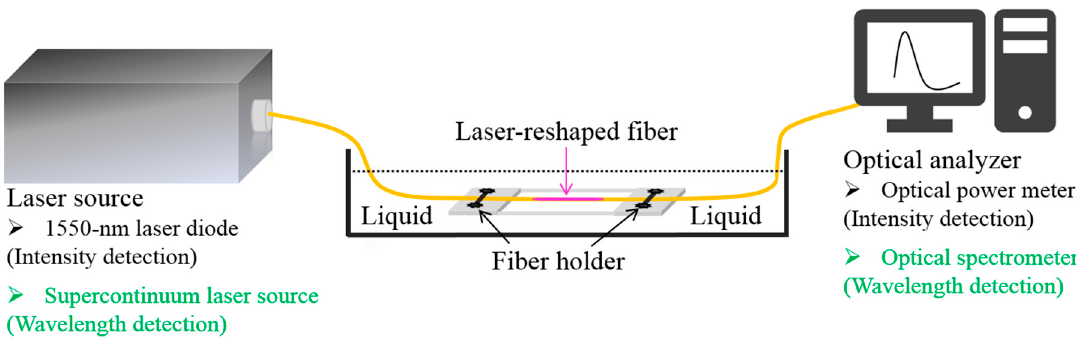
Figure A3. Configuration of the measurement setup which could be used for practical testing of the proposed RI sensor.